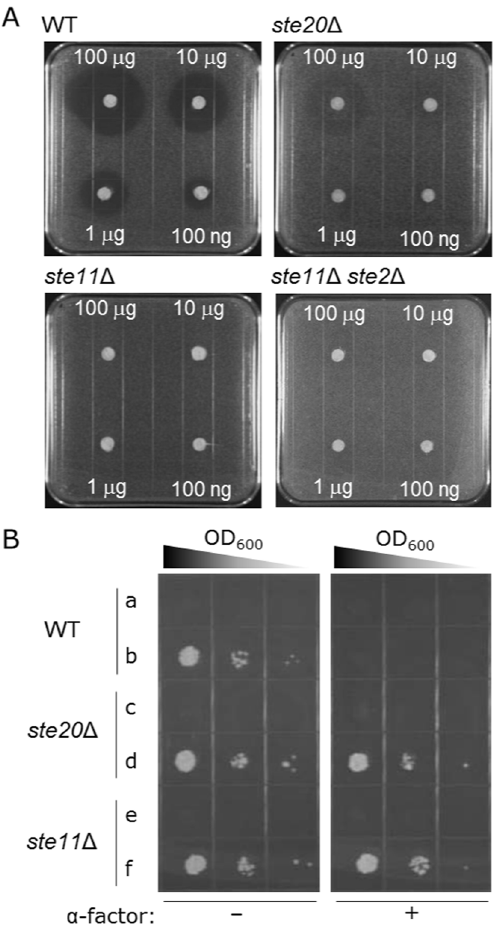
Figure 2. ste11 D allele allowed more strict avoidance of signal- promoted growth arrest in the presence of ligand. (A) Halo- bioassay (agonist-induced growth arrest assay) for STE20 -, STE11 - and STE2 -gene-disrupted strains: NMY51 (WT); NMY61 ( ste20 D ); NMY62 ( ste11 D ); and NMY63 ( ste11 D ste2 D ). Each paper filter disk was spotted with the indicated amount of a -factor. (B) Growth assay of NMY51 (WT; a,b ), NMY61 ( ste20 D ; c,d ) and NMY62 ( ste11 D ; e,f ) strains on SD –Leu, Trp, Ade and His dropout plates. Yeast strains harboring pBT3-C/pPR3-C or pCCW-Alg5/pAI-Alg5 respectively expressed Cub/Nub G (negative control; a,c,e ) or Alg5-Cub/Alg5-Nub I (positive control; b,d,f ). Each cell was spotted in serial 10-fold dilutions on selective agar plates with or without 5 m M of a -factor. Nub I is a WT Nub tag and interacts spontaneously with Cub.